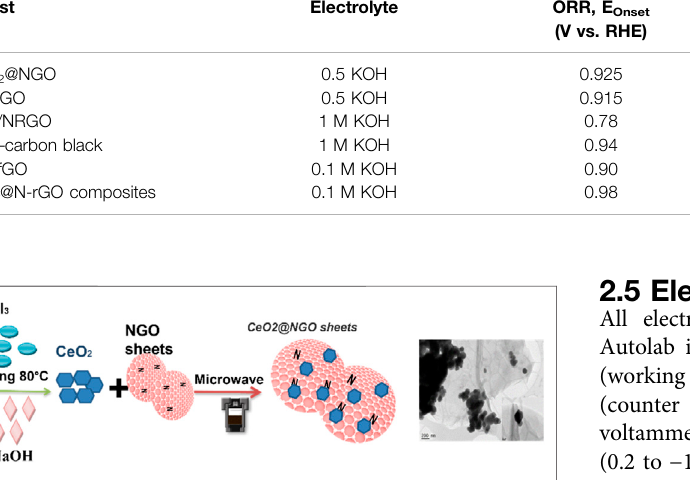
TABLE 1 | Comparison of the electrocatalytic activity of 1-CeO 2 @NGO composites with different metal oxides of OER/ORR electrocatalysts that have been recently reported. Catalyst Electrolyte ORR, E Onset